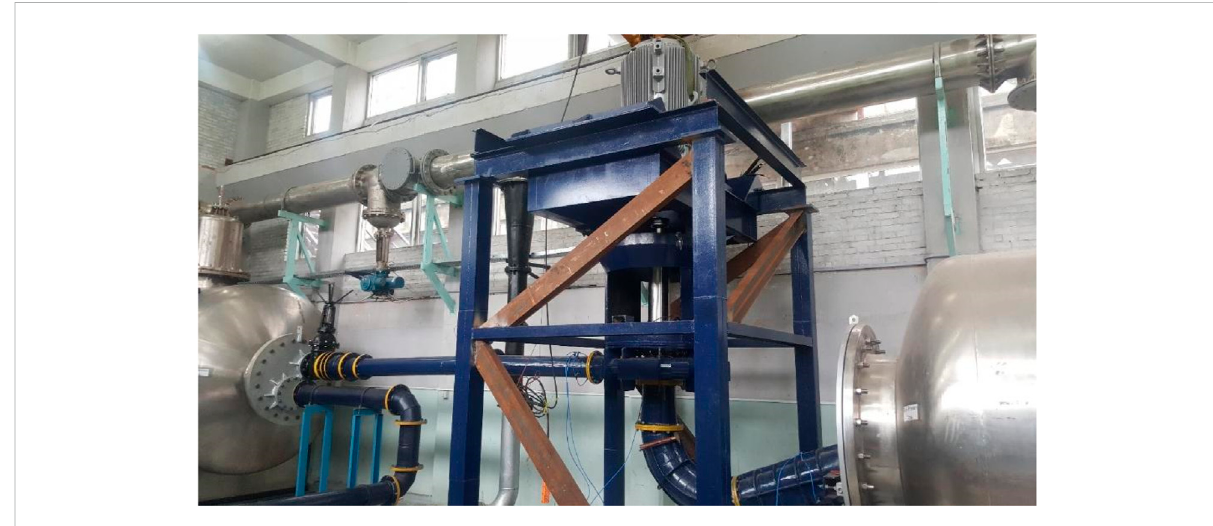
FIGURE 9 Francis turbine test rig under construction at Turbine Testing Laboratory (TTL) at Kathmandu University in Nepal (Thapa,